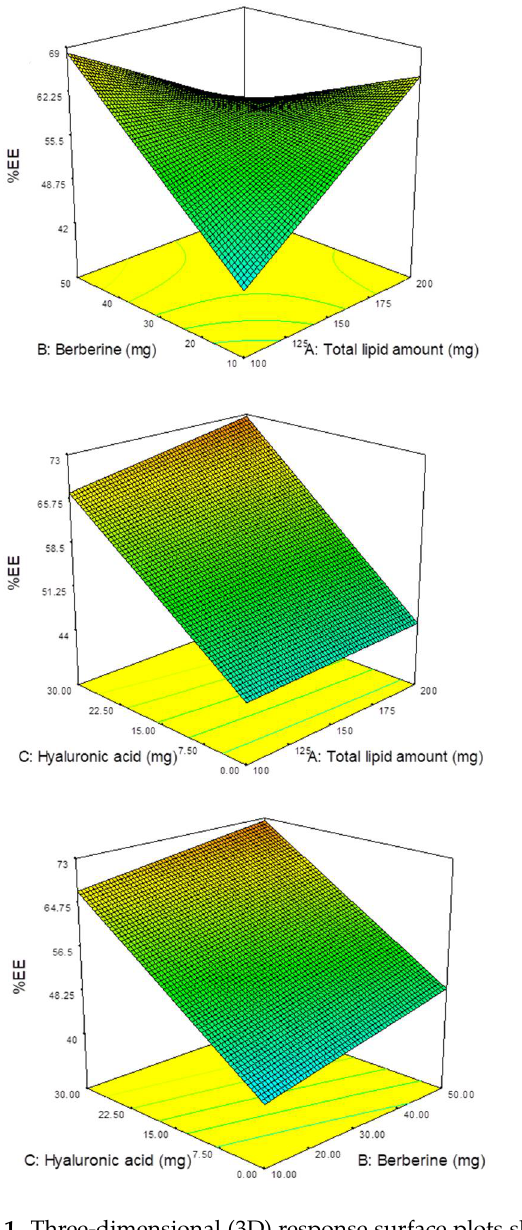
Figure 1. Three-dimensional (3D) response surface plots showing the effect of the independent variables on liposomes particle size and entrapment efficiency percent: A—total lipid amount (mg), B—berberine (mg), C—hyaluronic acid